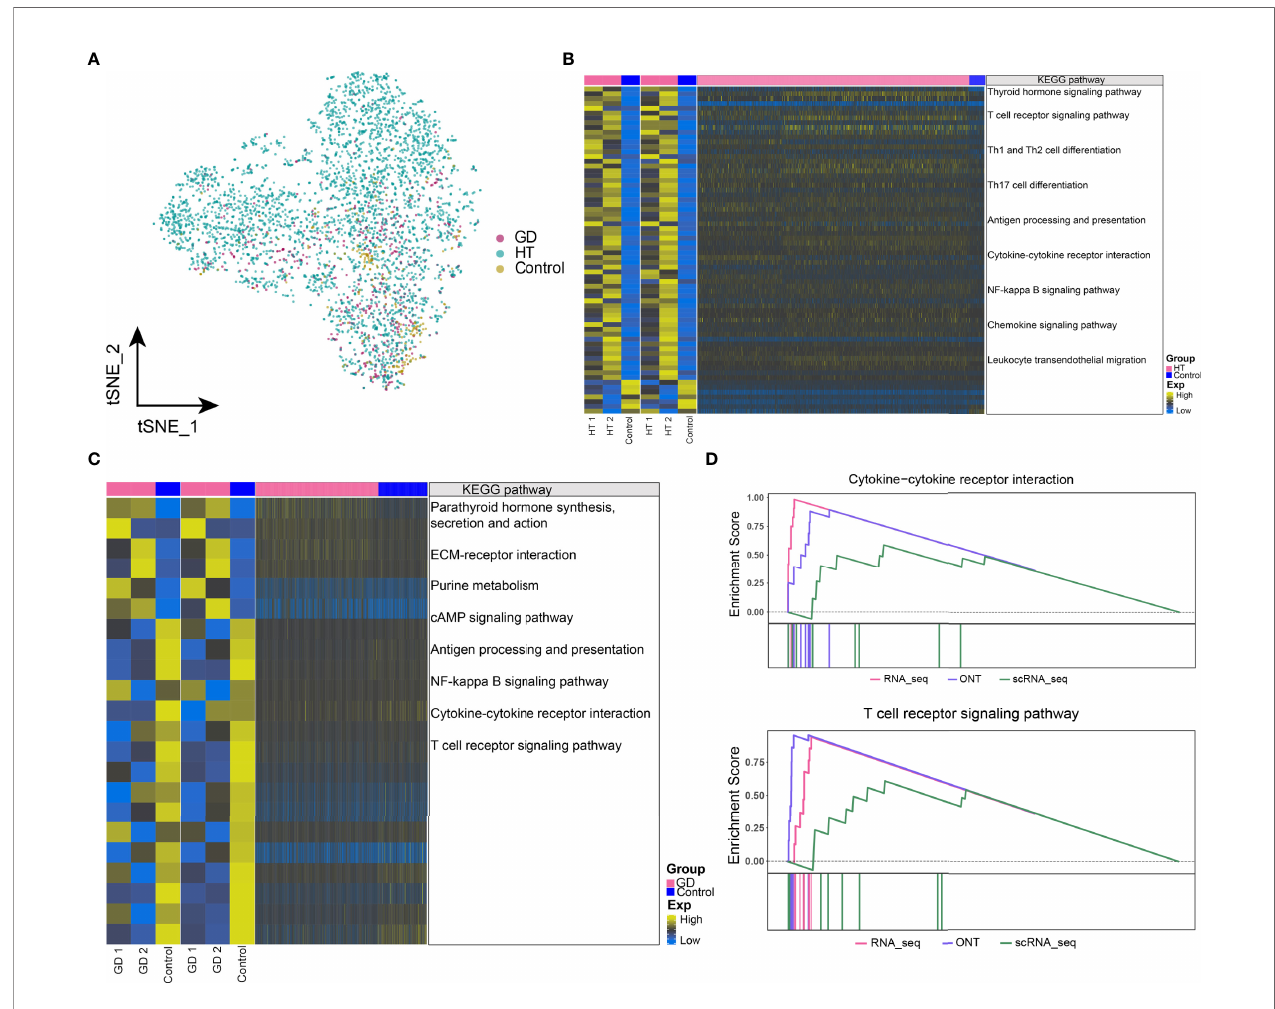
FIGURE 4 | Dysregulated gene expression and abnormal metabolic signaling in microenvironmental CD4 + T cells in HT and GD. (A) Single-cell tSNE plots demonstrating HT, GD, and control microenvironment CD4 + T-cell pro fi les. (B, C) KEGG pathway involved in genes with high-con fi dence dysregulated expression in bulk level and CD4 + T cells in HT (B) and GD (C) patients. Heatmap of DEGs from ONT sequencing on the left, heatmap of DEGs from RNA sequencing in the middle, and heatmap of DEGs from CD4 + T cells on the right. (D) Composite GSEA plot demonstrating the KEGG pathway of signi fi cant dysregulation of microenvironmental CD4 + T cells in HT. EXP, expression; GD, Graves ’ disease; HT, Hashimoto ’ s thyroiditis; KEGG, Kyoto Encyclopedia of Genes and Genomes; ONT, Oxford Nanopore